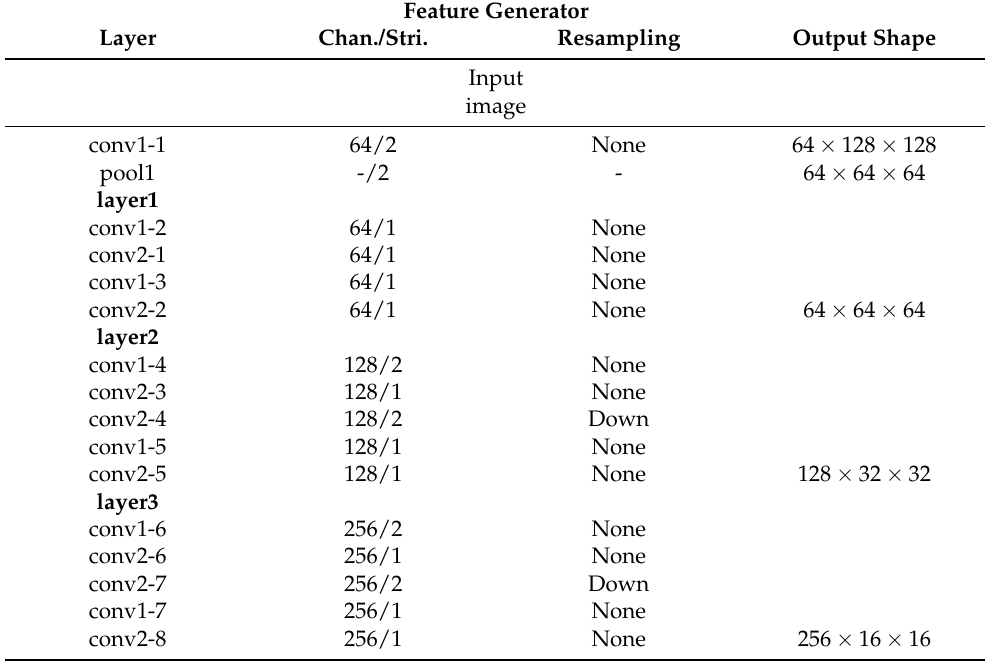
Table 1. Details of feature